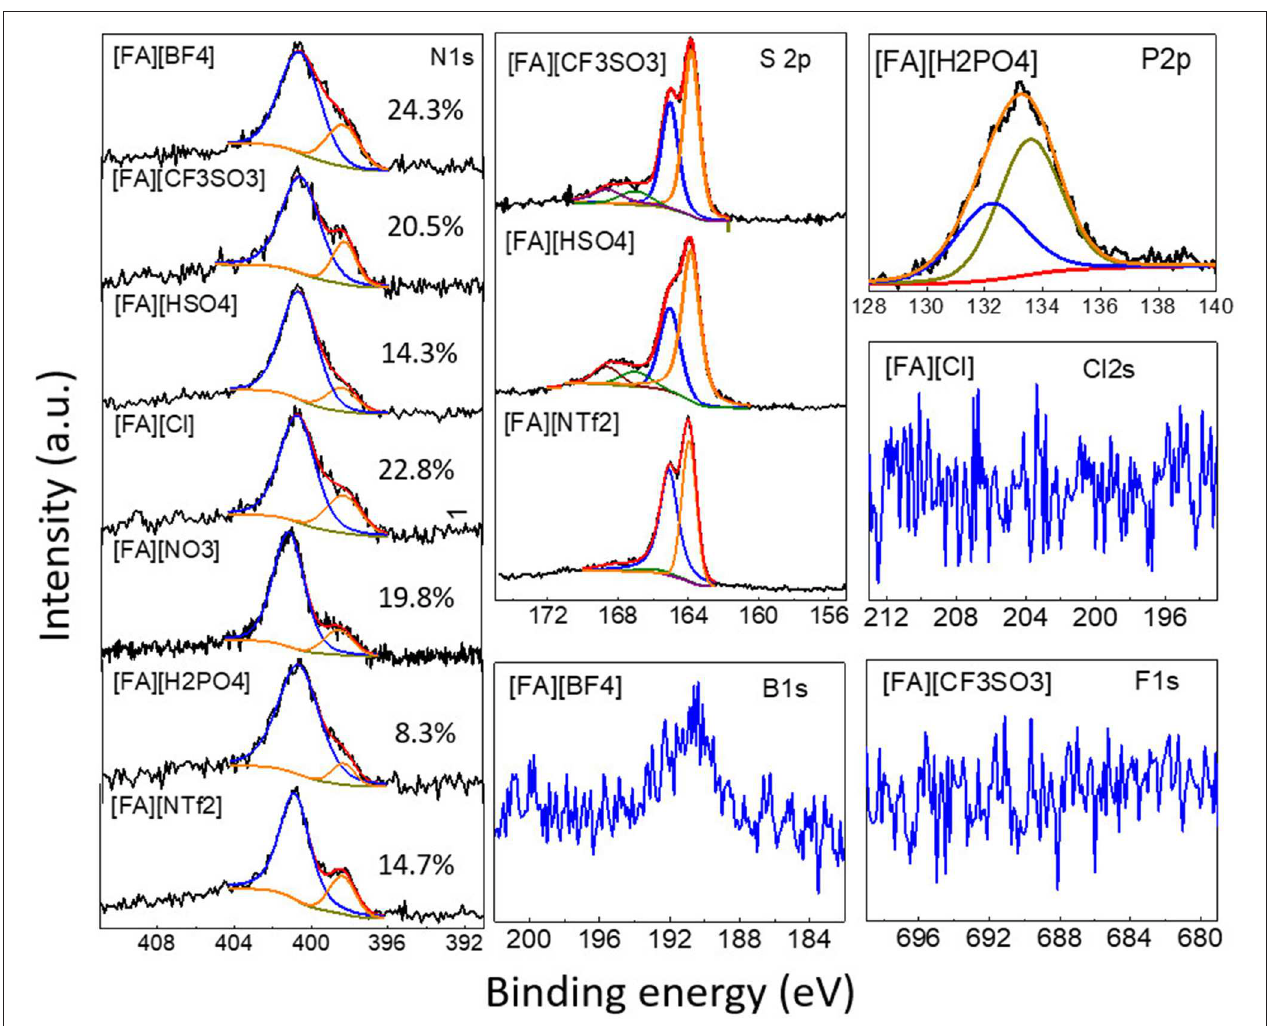
FIGURE 6 | High-resolution N 1s, S 2p, B 1s, P 2p, Cl 2s, and F 1s XPS spectra of [FA][X]-derived carbons. Numbers in the N 1s spectra indicate the percentage of pyridinic N.